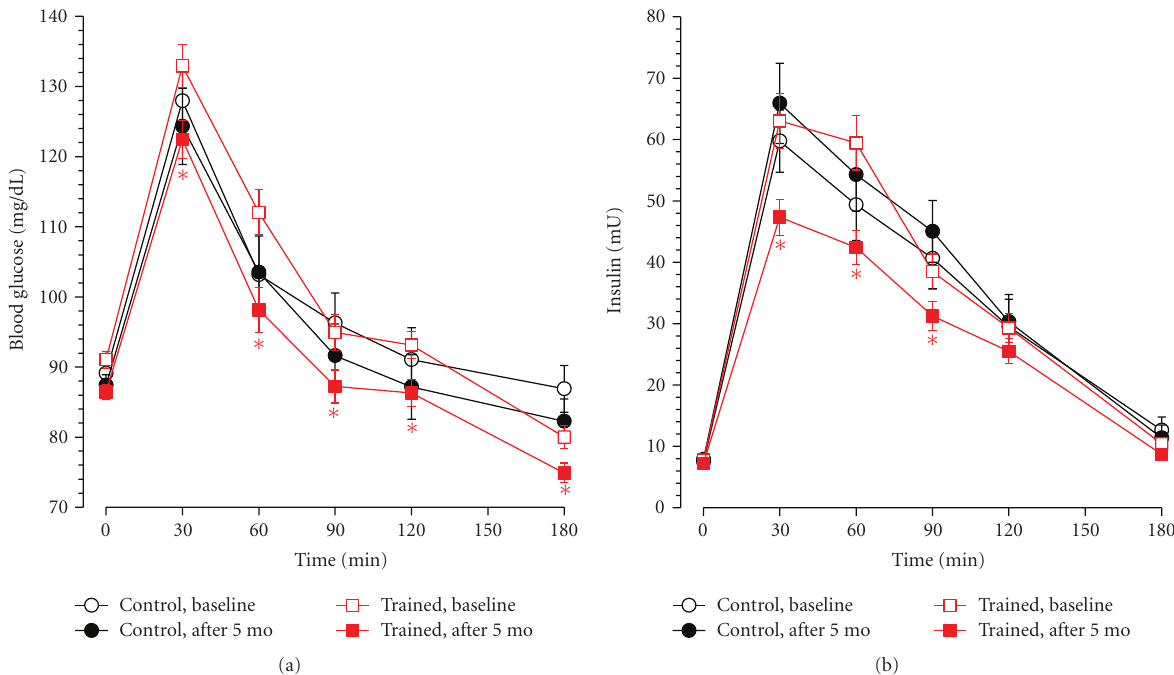
Figure 2: Blood glucose and plasma insulin concentrations during GTT in control and trained subjects at the beginning and at the end of the study . Blood glucose (a) and insulin (b) mean levels in control (black circles) and trained (red squares) subjects at baseline (open symbols) and after 5 months (closed symbols). Vertical bars are standard errors. Asterisks indicate significant decrease of blood glucose (a) and insulin (b) in the trained subjects after training compared to their respective baseline values ( P < . 01). In contrast, no decrease between baseline values and those at the end of the study was observed in control subjects. The insulin decrease in trained subjects at 60 and 90min also di ff ered significantly from the control group ( P < . 01 and < . 05,